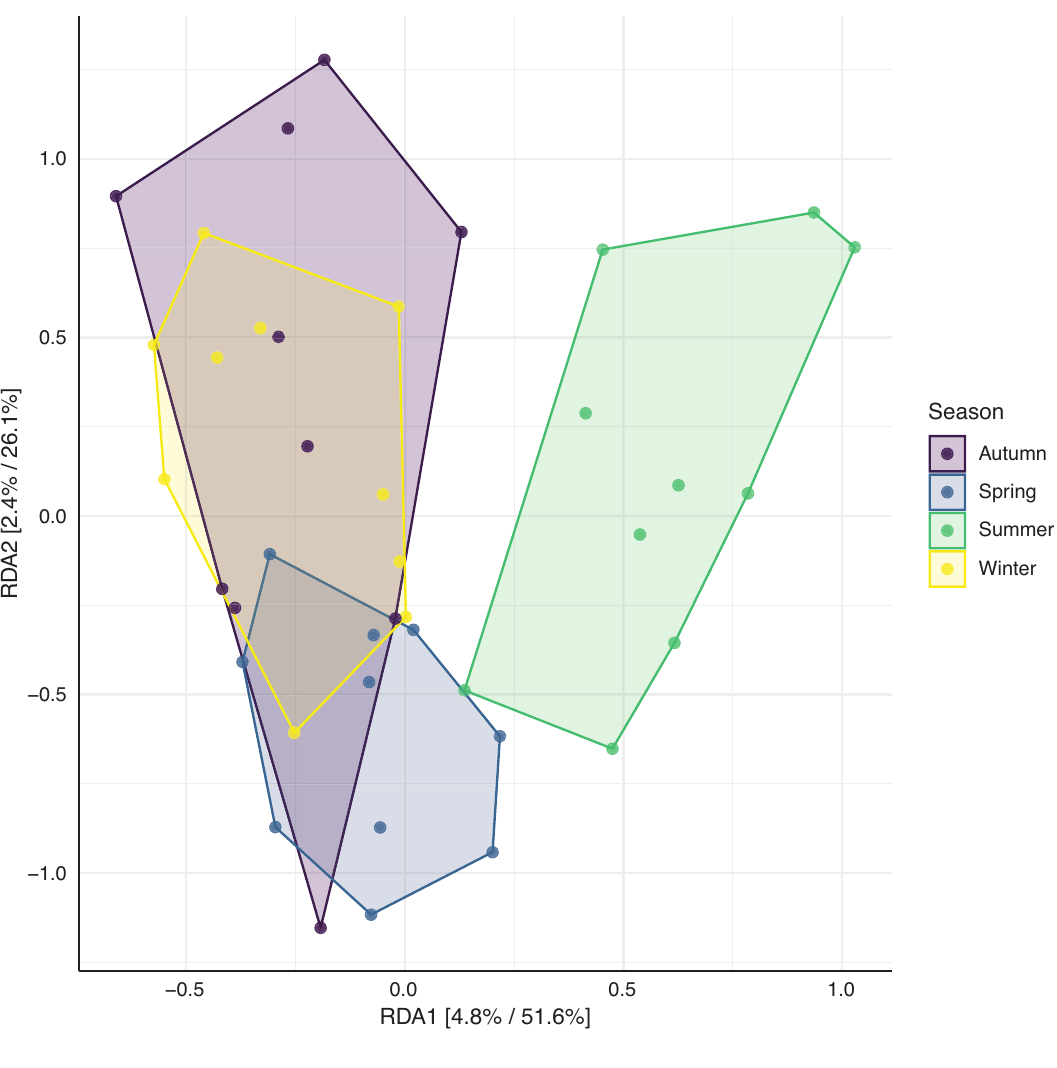
RDA (redundancy analysis) plotting of airborne bacteria in homes constrained by the season; circles represent an individual sample. Percentages on the axes refer to the relative contribution (eigenvalue) of each axis to the total inertia in the data and the relative contribution of the particular axis to the total constrained space. Samples are coloured by season, and a polygon is drawn around samples representing the same season. ANOSIM: R 2 = 0.08, P = 0.009. (Source: Authors,